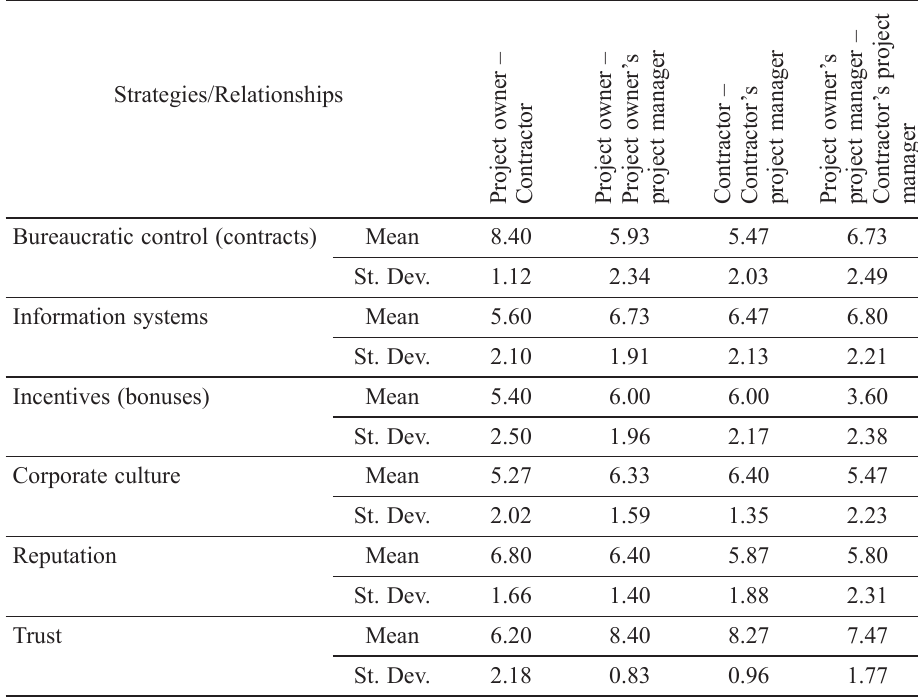
Table 1. Results of the survey